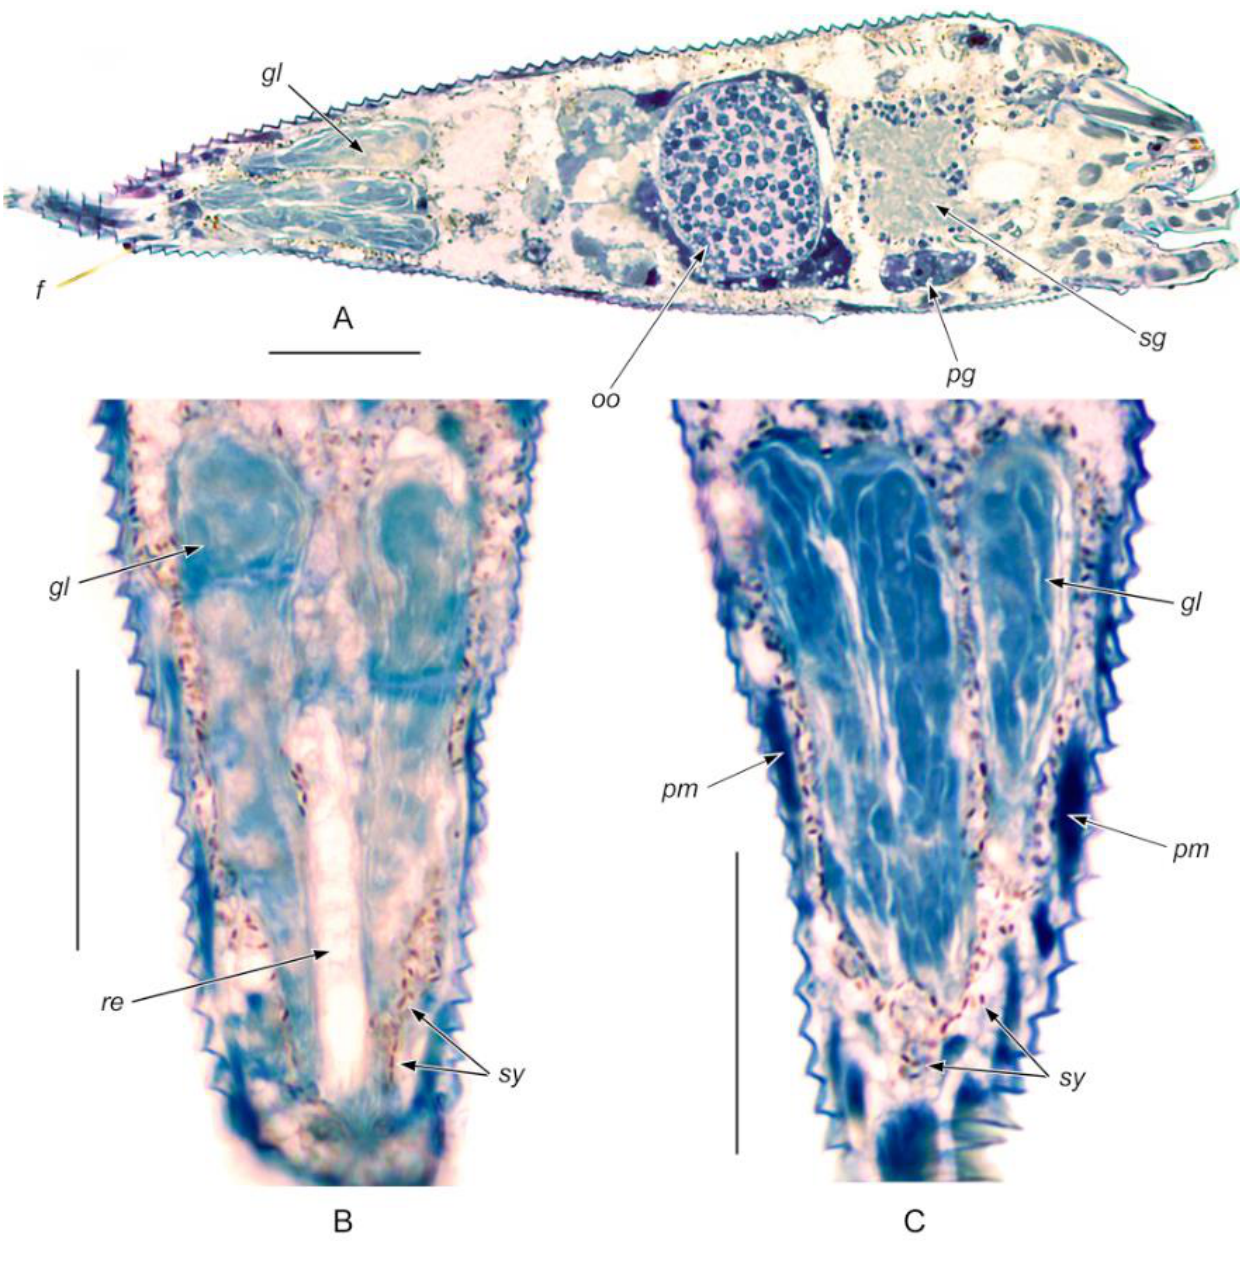
Figure 11. Frontal semi-thin sections of Aberoptus schotiae n. sp. (LMSSS). ( A ) — entire mite in dorsoventral position, ( B , C ) — caudal part of opisthosoma containing silk-producing anal secretory apparatus. Notations: f — opisthosomal seta f , gl — silk gland, re — anterior part of rectum, oo — oocyte, pg — paired gland, pm — peripheral muscles, sg — synganglion, sy — symbiotic bacteria. Scale bars: ( A ) = 30 µm; ( B , C ) = 20 µm.